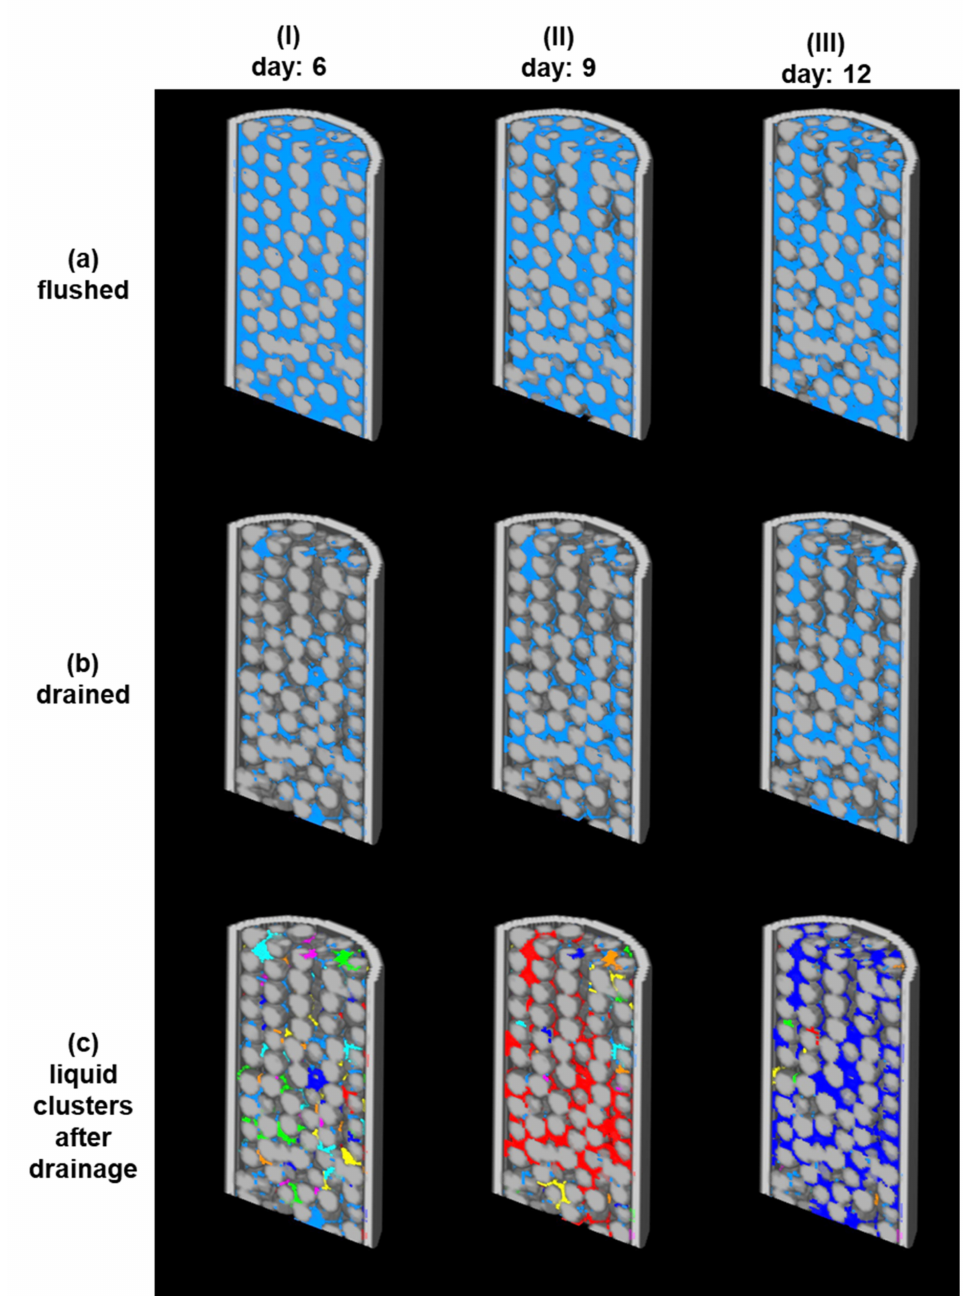
Figure 4. Processed 3D images on days 6, 9, and 12 ( a ) in the flushed condition, ( b ) in the drained condition, and ( c ) analyzed for liquid clusters. Solid material (glass column; porous medium) is superpositioned and displayed in grey. The liquid phase is presented in blue. Air is removed from the visualization (transparent areas). Based on row ( b ), the liquid phase was analyzed for connectivity and divided into isolated liquid clusters. Each color represents a separate liquid cluster. Please note that more liquid clusters than colors are shown in ( c ); therefore, one color might also represent multiple isolated liquid